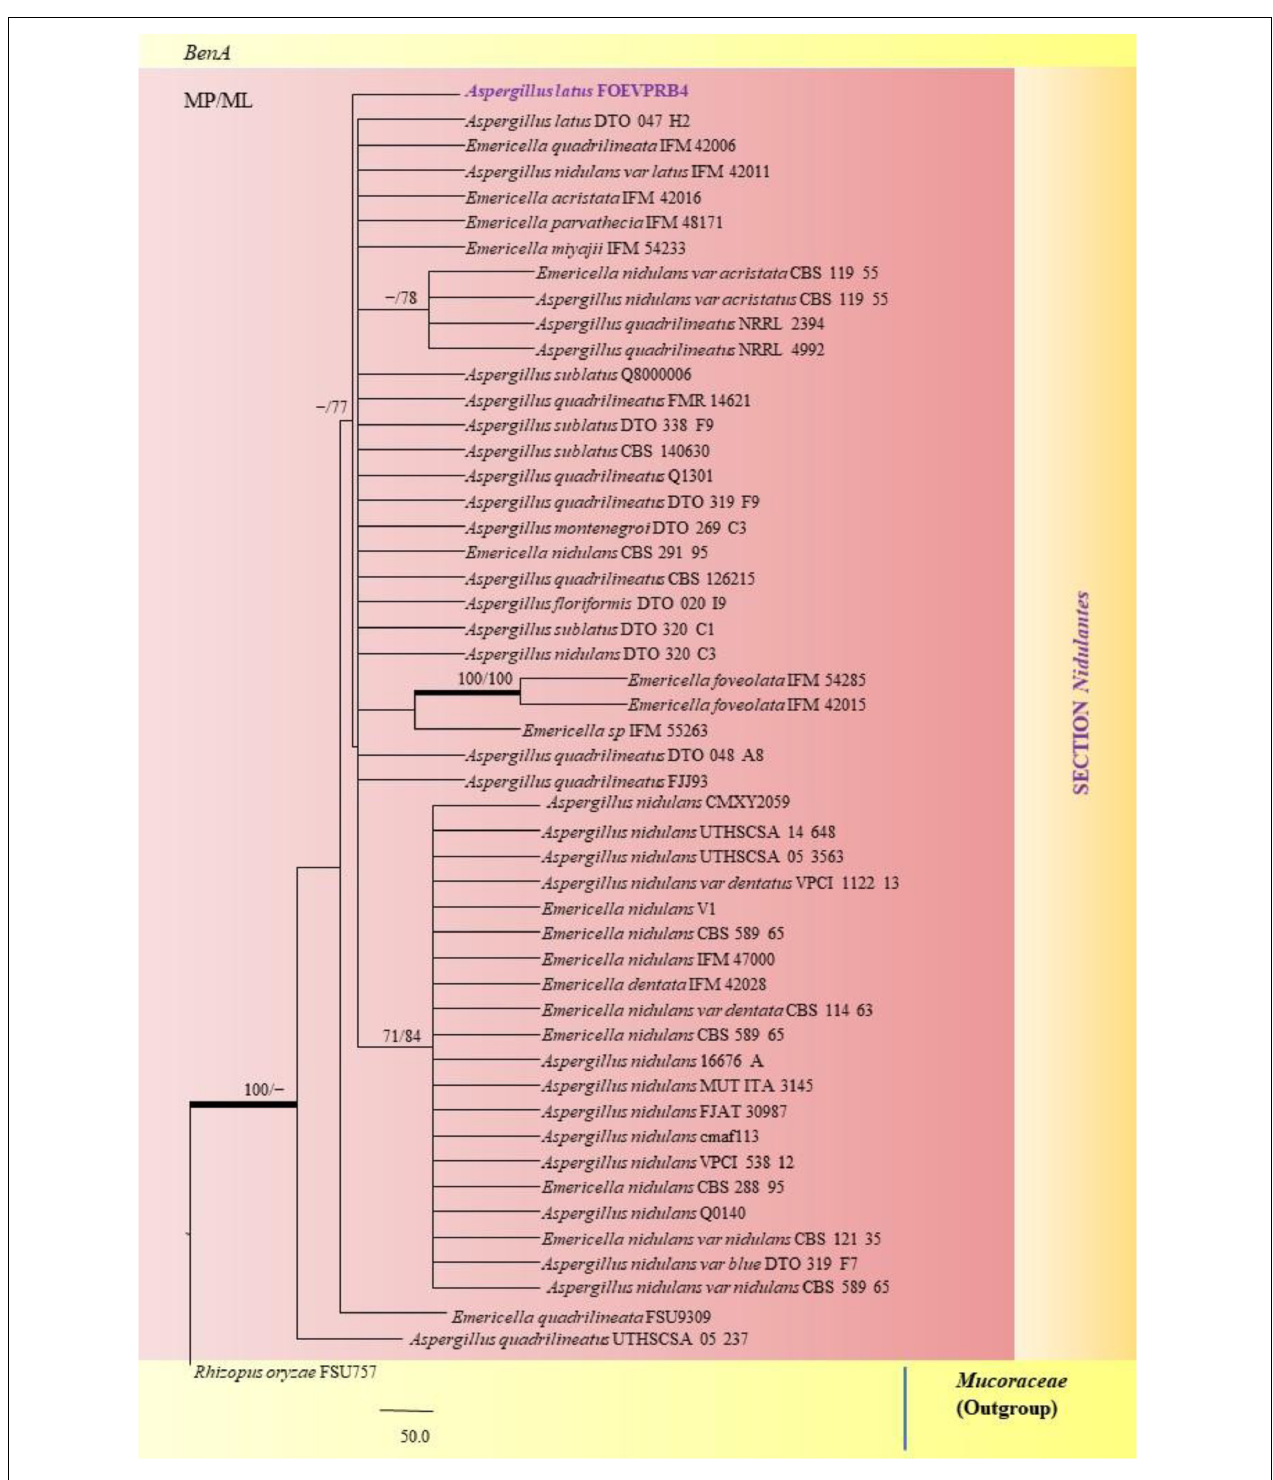
FIGURE 9 | A phylogenetic tree (taxon branching diagram) which presents the genetic analysis of the Aspergillus latus FOEVPRB4 clade belonging to the Section Nidulantes, exhibiting a maximum parsimony analysis of partial β -tubulin concatenated sequences, acquired. Bootstrap (bs) values ≥ 70% are designated at the nodes for maximum parsimony (MP) and maximum likelihood (ML) methods; branches with values ≥ 95% bs are bold black. A specific isolate code was mentioned as a suffix to the species name. Hyphen (-) represents the range of support values for parsimony and RAxML analyses of below 70%. Our isolate, which is marked in purple, was rooted using Rhizopus oryzae